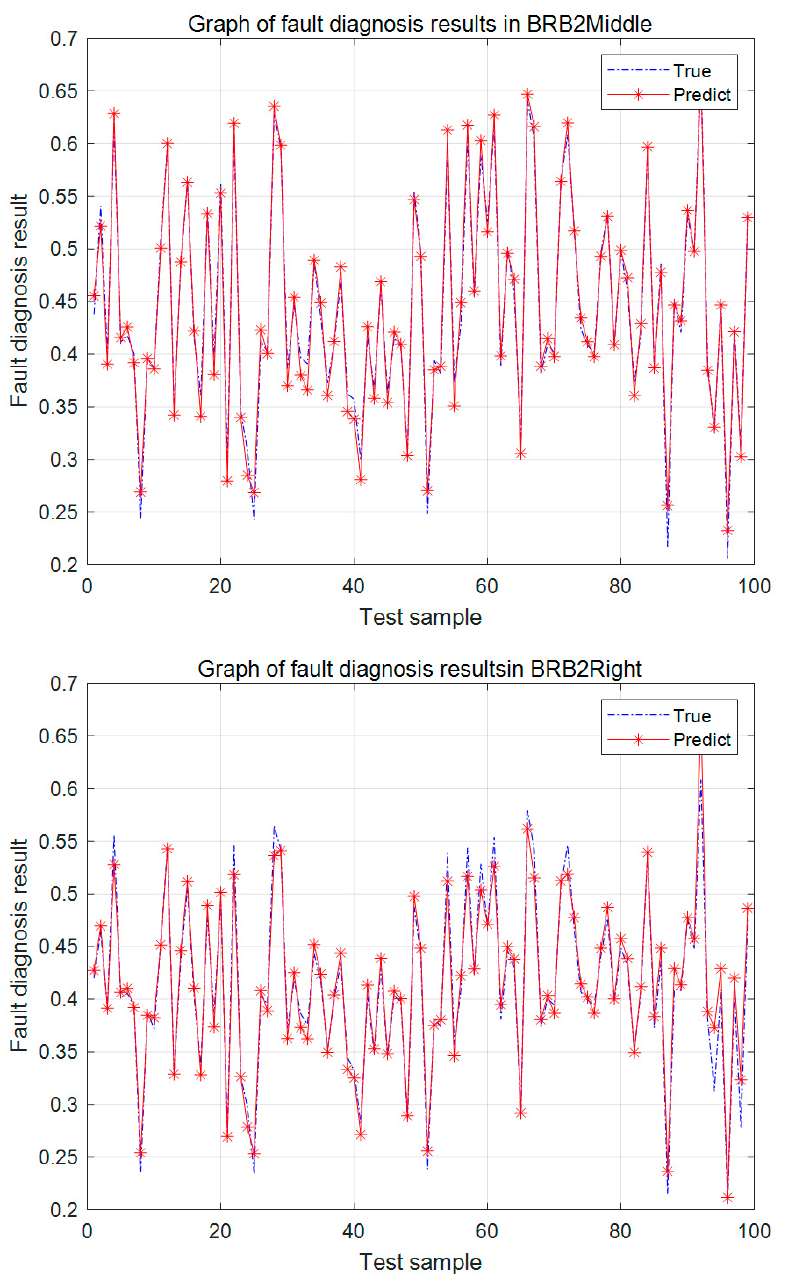
Figure 11. Fitting diagram right of experimental results and real values.